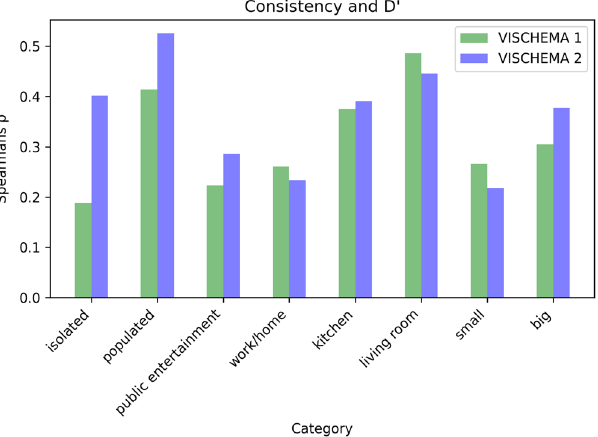
Figure 1. Histogram showing the correlation between per image category consistency for Vischema 1 and 2 datasets and human observers’ memory. Similar pattern of correlations between datasets indicates the reliability of using Visual Memory